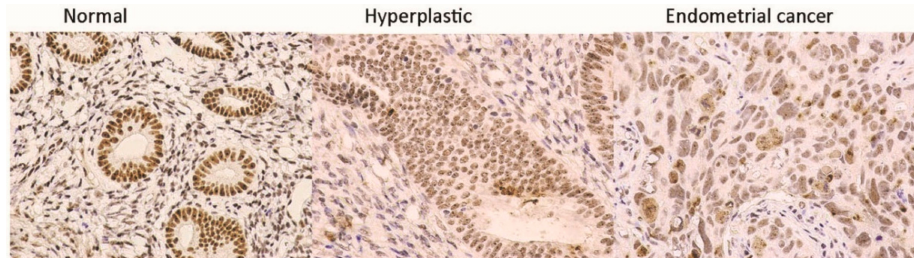
Figure 2. Micrographs of three separate endometrial samples obtained from the same patient, containing normal endometrial glands, hyperplastic glands and frank endometrial cancer tissue. The exact pathology included in the part of the sample studied with high throughput methods will directly influence the data generated. As shown here, the three separate parts of the endometrium biopsied from the same hysterectomy sample contained a histologically di ff erent pathological phenotype in the epithelial